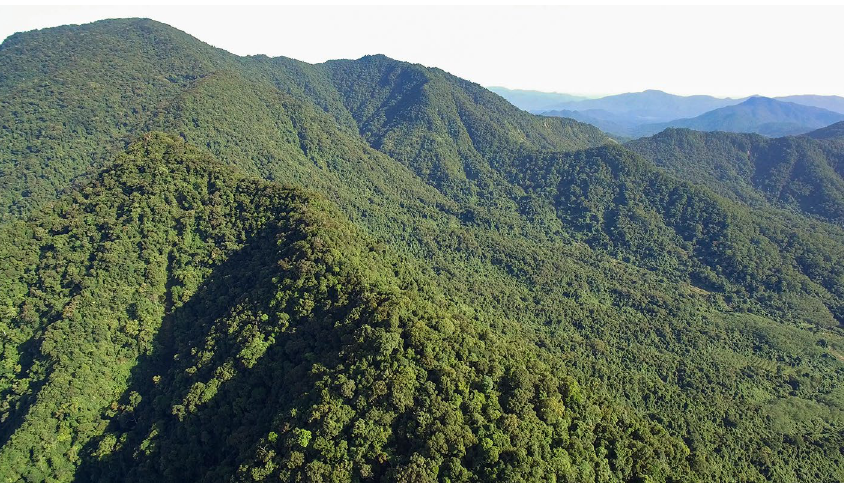
Figure 5. Landscape of the study area (Xiaofutouling is in the foreground), taken on 21 June 2018. Photograph taken by